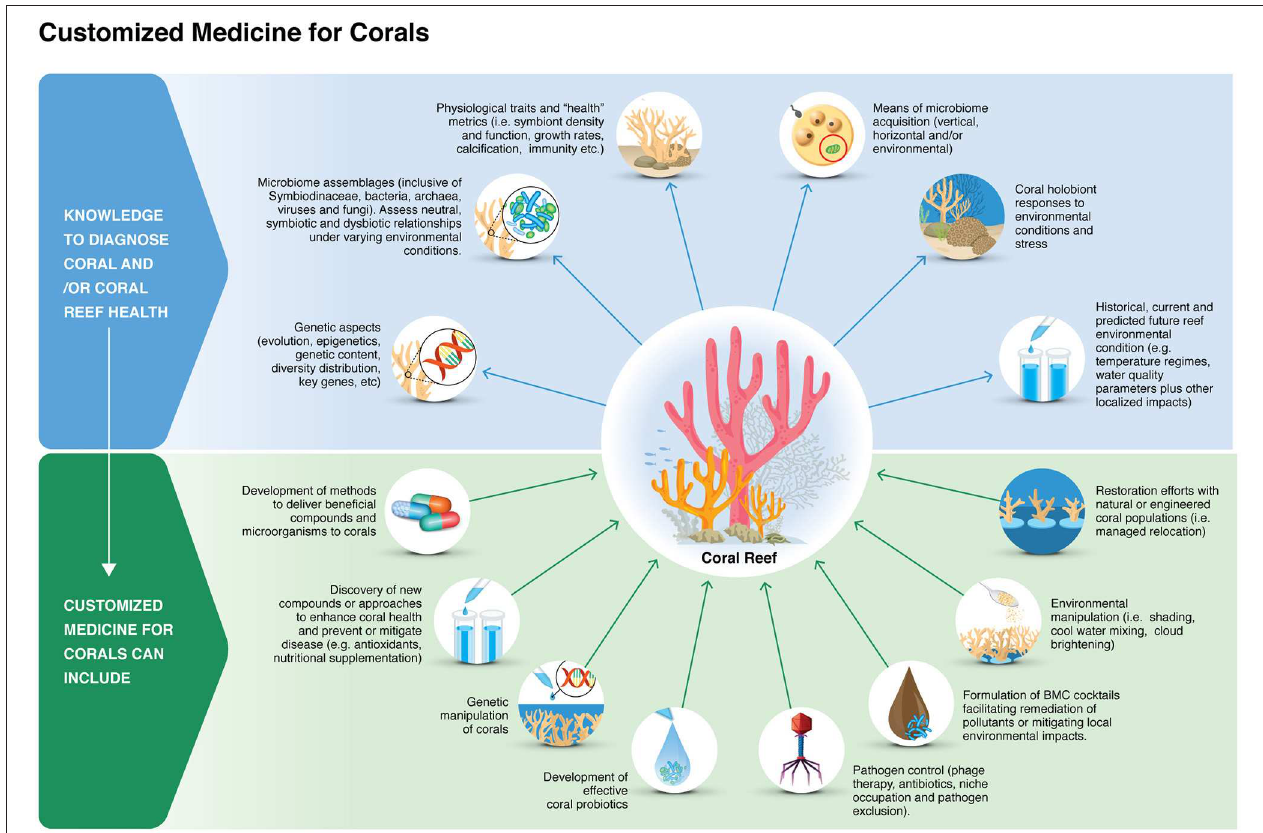
FIGURE 1 | Examples of key topics and approaches to be explored to support the development of interventions to increase coral reef resilience.